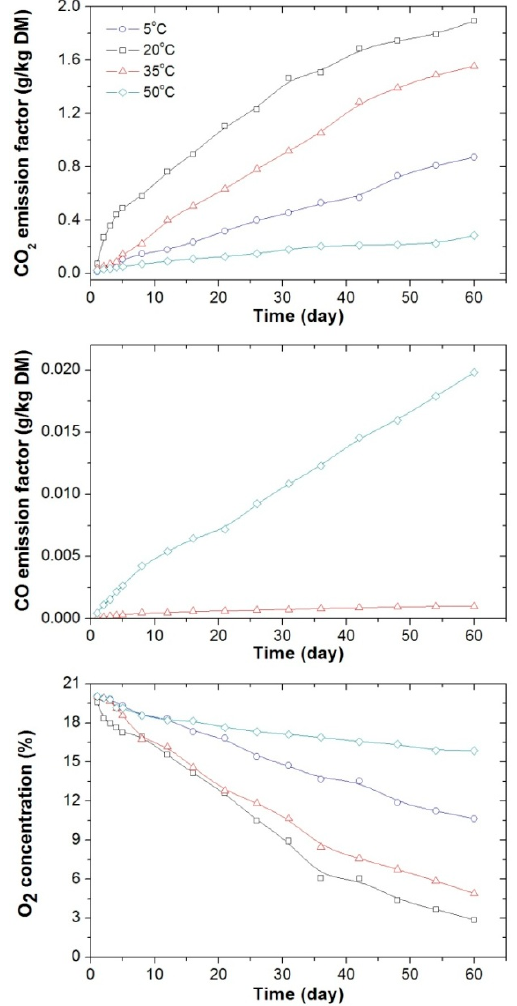
Figure 3. Gas emission profiles from WRC chips with initial moisture content of 35% under non-aerobic condition.